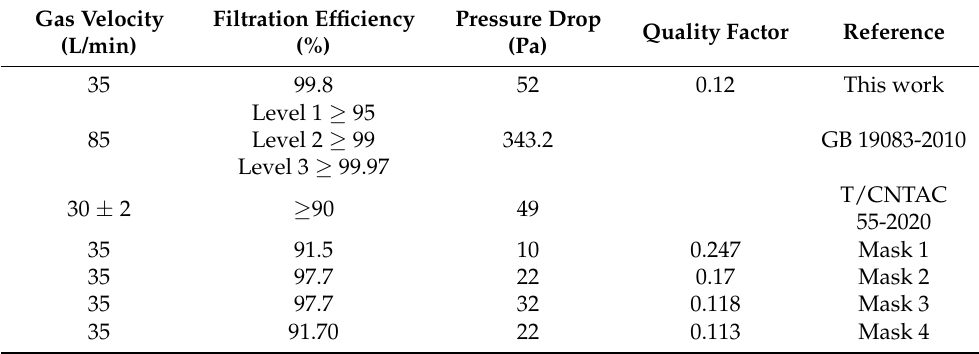
Table 1. Comparison of filtration performance between CA/TPU-1LiCl fiber membrane and related mask standards and commercial masks.